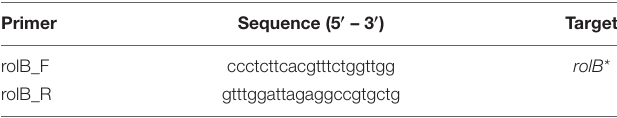
TABLE 2 | Oligonucleotide PCR primers used in this